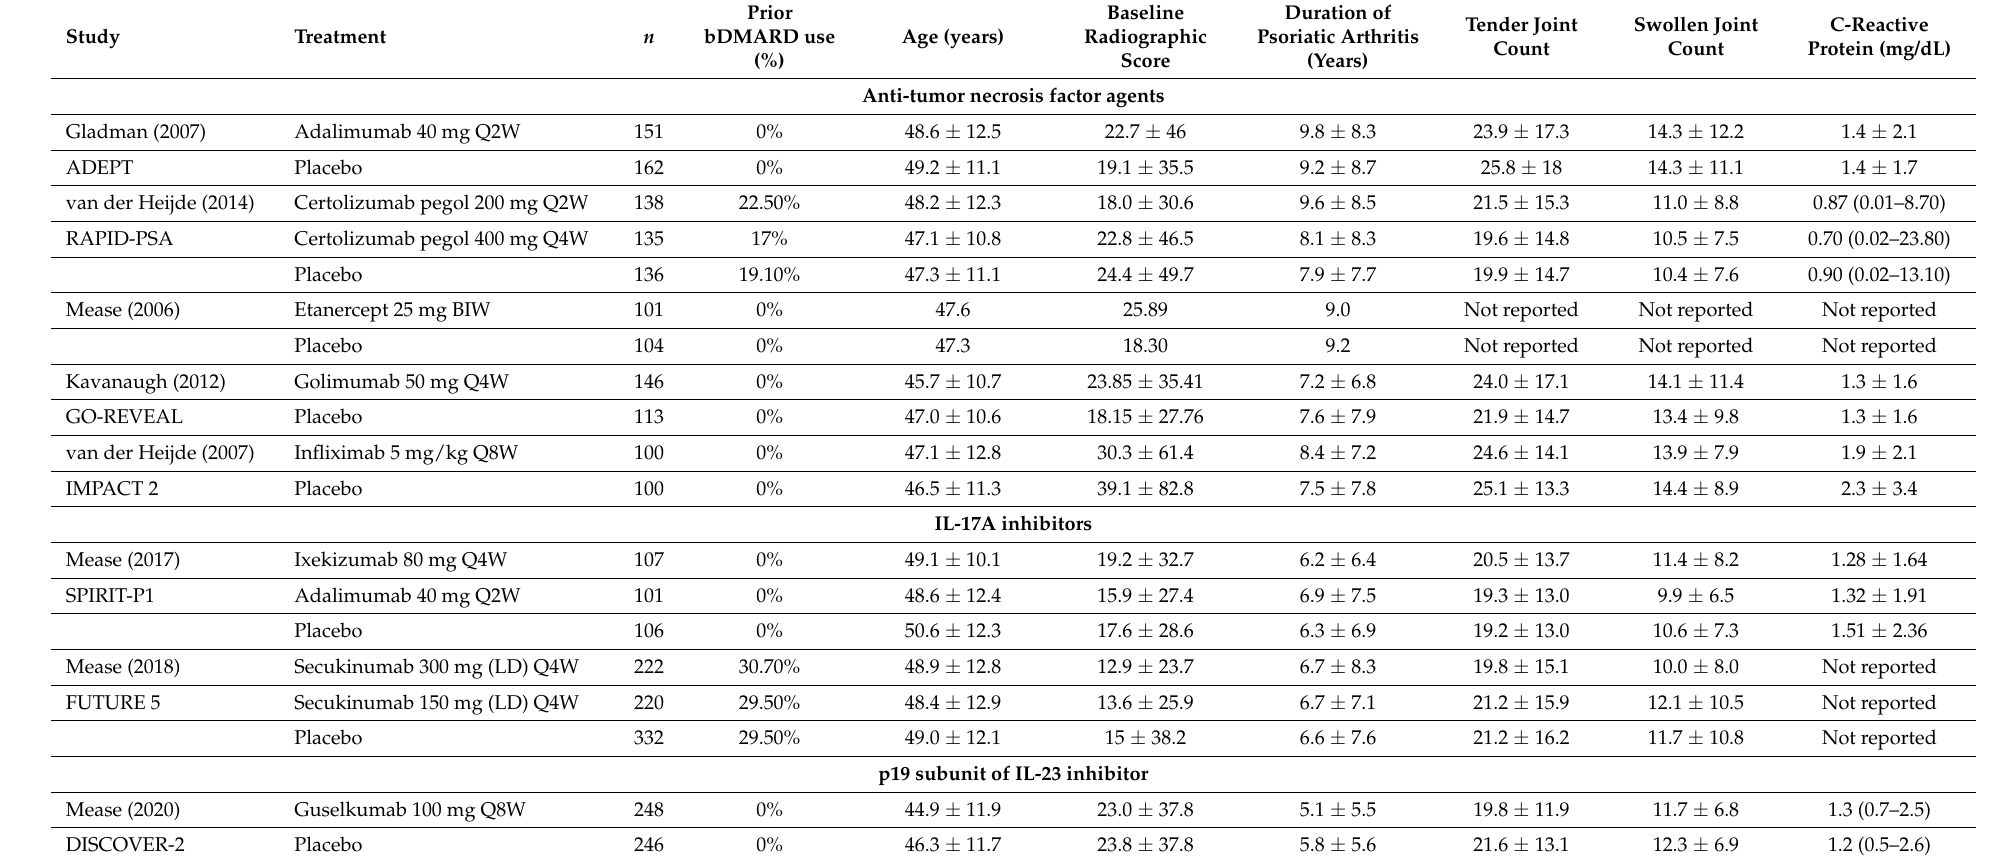
Table 1. Baseline characteristics of included